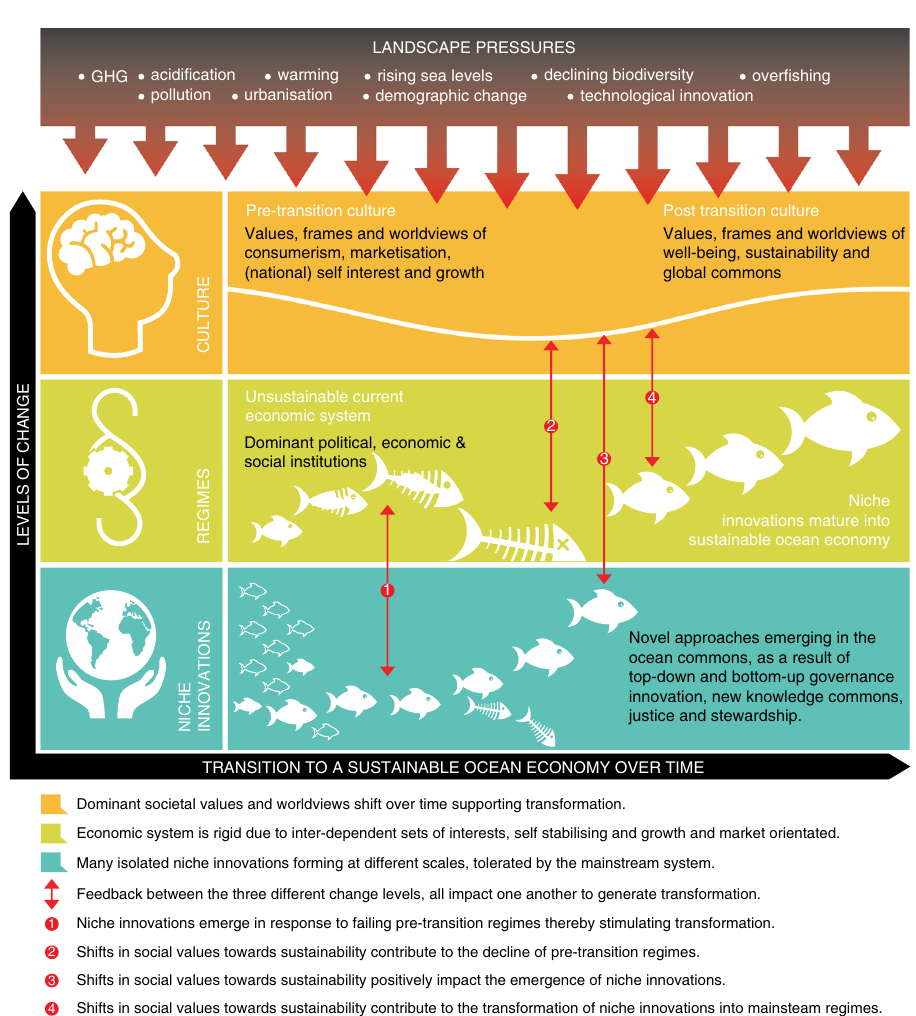
Fig. 1 Dynamics of system-level change in the ocean economy. The elements of the ocean social-economic system undergoing systemic change as a result of interactions between culture, existing regimes, and niche innovations, all of which are in fl uenced by landscape pressures. Redrawn from Narberhaus and Sheppard 116 , with permission from the author and in compliance with the CC BY-SA 3.0 license, 2015 https://creativecommons.org/